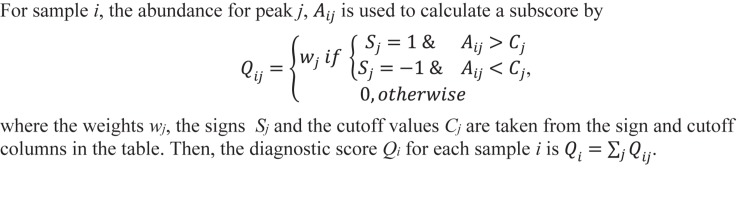
Breath score algorithm derived from the six predictive VOCs using the sign, cutoff, and weighting information in Table 2. Qij is the breath score referred to in this work.